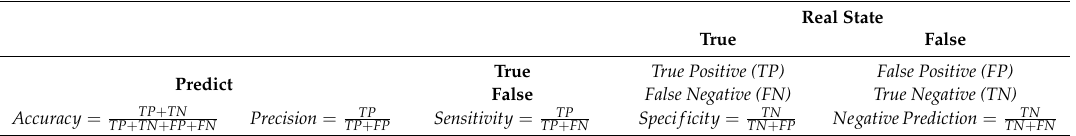
Table 1. Prediction and allocation table and related